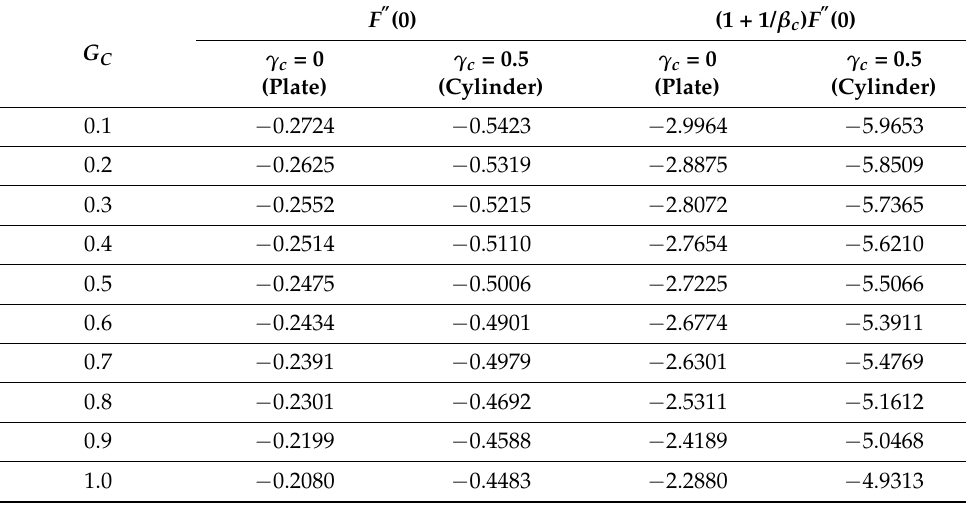
Table 5. Variation in SFC for G C